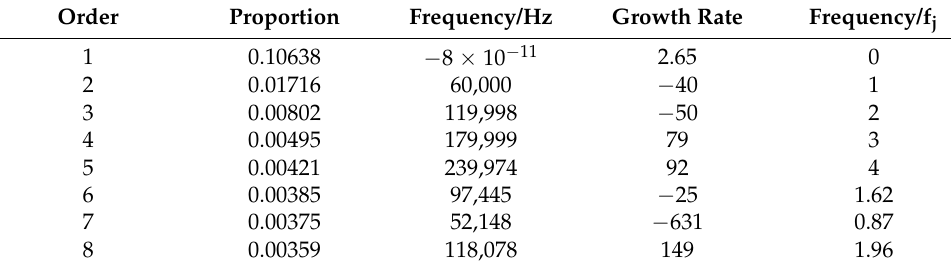
Table 7. Modes’ characters of the first eight modes in Case